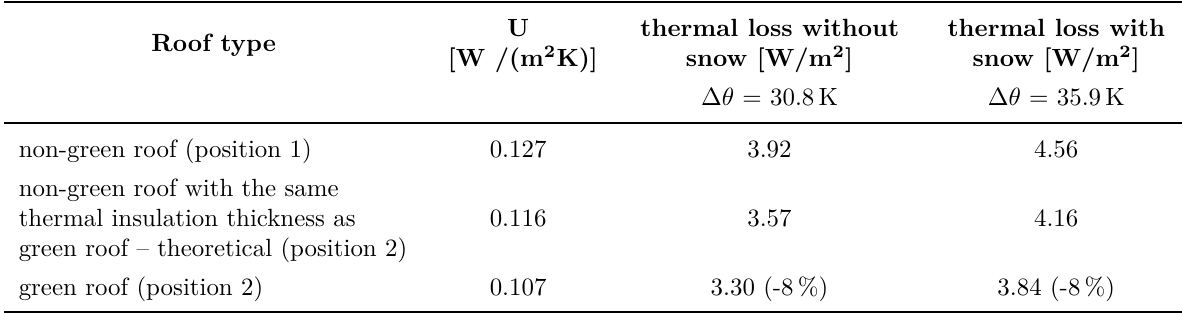
Table 2. Calculated U-values and thermal loss based on climate temperatures ( θ